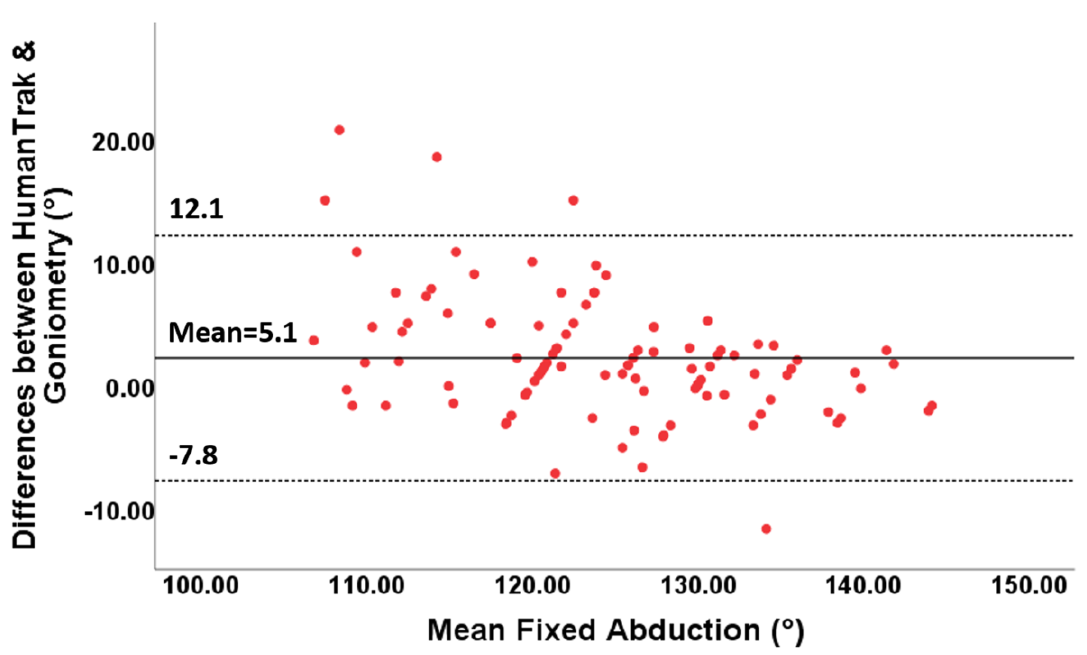
Figure 9. Bland–Altman plots for fixed abduction with limits of agreement. The differences between the two devices are plotted on the Y-axis, and the mean scores are plotted on the X-axis.